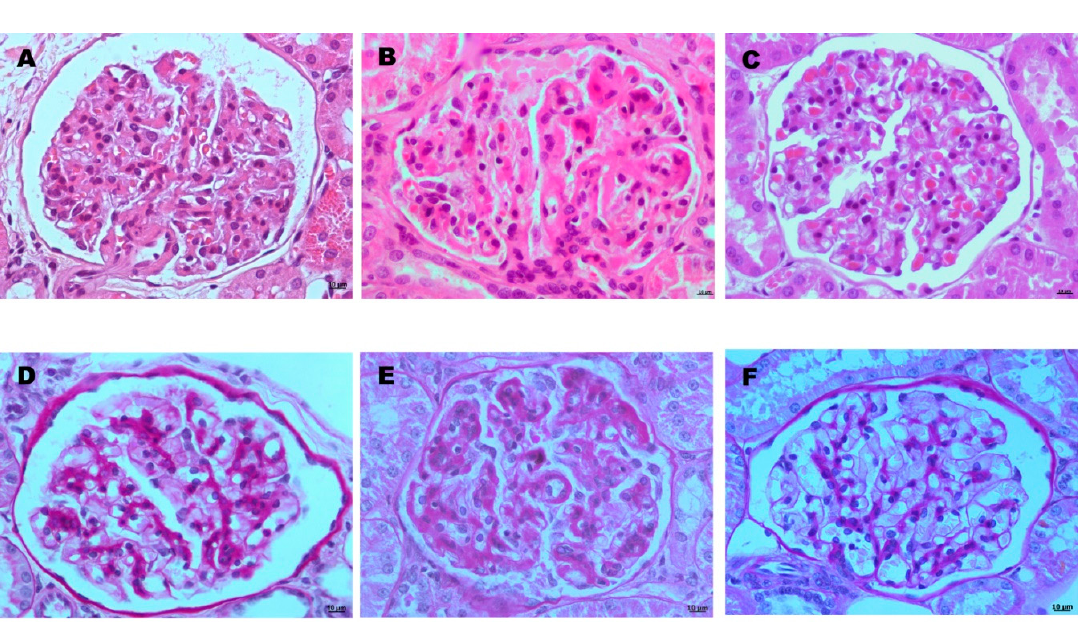
Figure 3. Representative microphotographs of glomerular lesions in dogs experimentally infected with Leishmania infantum ( A , B , D , E ). ( C , F ) correspond with control dogs showing normal glomeruli. ( A – C ) are stained with Hematoxylin and Eosin (H-E) and ( D – F ) with Periodic Acid-Schiff (PAS), and all have an original magnification of 400×. ( A , D ): Mesangioproliferative glomerulonephritis. Note groups of three mesangial cells ( A ), hallmark of this type of glomerulonephritis in dogs and moderate increase in mesangial tissue ( D ). ( B , E ): Membranoproliferative glomerulonephritis. Note the marked increase in basal membranes, best observed with PAS staining ( E ). A mild increase in cellularity is observed in some areas ( E ).